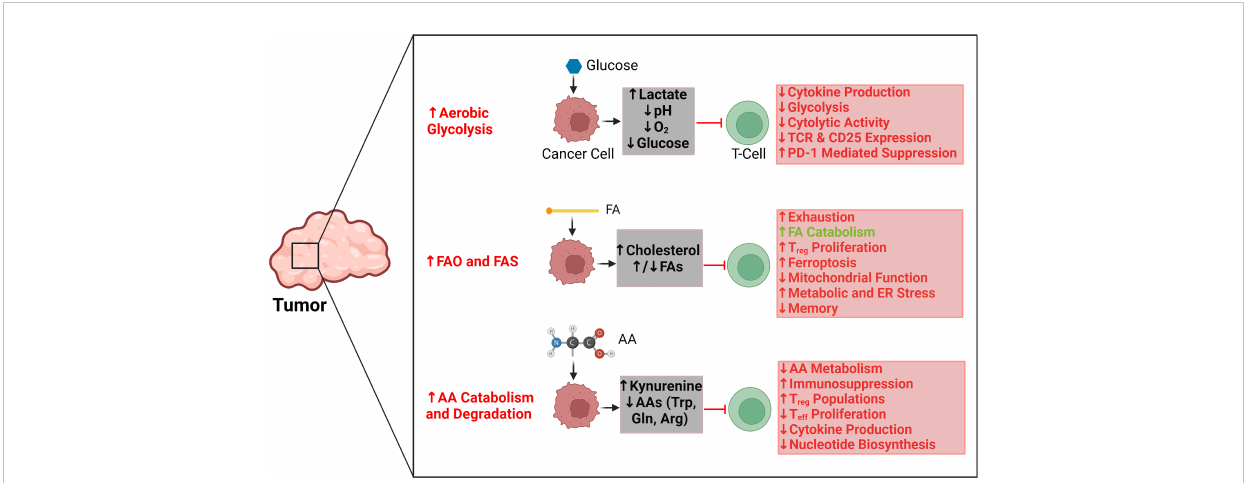
FIGURE 1 Key regulatory effects and interactions between tumor metabolic pathways and T-cell activity. Aerobic glycolysis in tumors is primarily responsible for creating a hypoxic, acidic, and nutrient-depleted microenvironment that suppresses effector T-cell activity and blunts antitumor immune responses. Similarly, the rapid uptake and catabolism of amino acids by tumors reduces their availability for T cells, which further promotes immunosuppression and supports the metabolic activities of regulatory T cells as opposed to effector T cells. Tumors can upregulate both fatty acid oxidation (FAO) and fatty acid synthesis (FAS), which affect T-cell activity differently. The accumulation of select fatty acids can support FAO in T cells; however, those same fatty acids can also promote exhaustion and inhibit the proliferation of memory T cells. Cholesterol is particularly signi fi cant for causing mitochondrial and endoplasmic reticulum (ER) stress in T cells. Red arrows and text indicate tumor metabolism – mediated effects that can suppress antitumor T-cell activity. Green arrows and text indicate tumor metabolism – mediated effects that can support antitumor T-cell activity. AA, amino acid; Arg, arginine; ER, endoplasmic reticulum; FA, fatty acid; FAO, fatty acid oxidation; FAS, fatty acid synthesis; Gln, glutamine; PD1, programmed cell death protein 1; T reg , regulatory T cell; T eff , effector T cell; TCR, T-cell receptor; Trp,